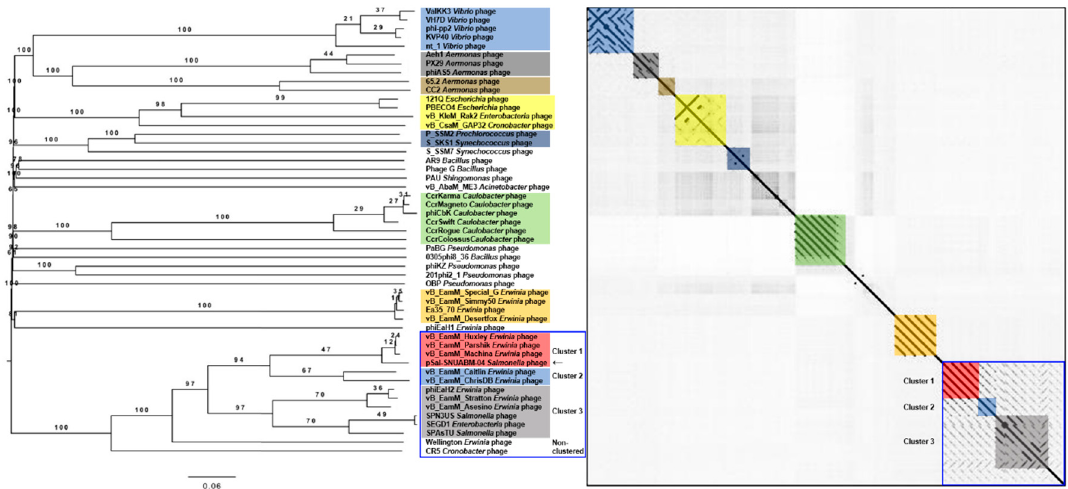
Figure 4. Comparative analysis of pSal-SNUABM-04 using whole-genome sequences. The phylogenetic tree was constructed using VICTOR with settings for prokaryotic viruses. The dot plot was generated with Gepard software at a word size of 10. Blue square; a large cluster composed of groups 1, 2, 3, and two non-clustered phages.